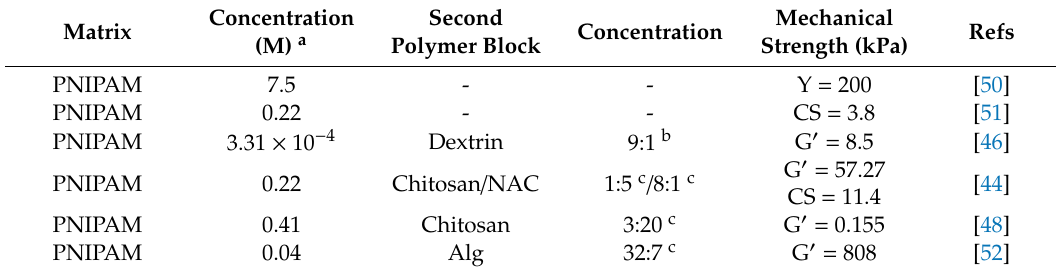
Table 1. Mechanical properties of the PNIPAM-based copolymeric hydrogels. Concentration Second Mechanical Matrix Concentration Refs (M) a Polymer Block Strength (kPa) PNIPAM 7.5 - PNIPAM